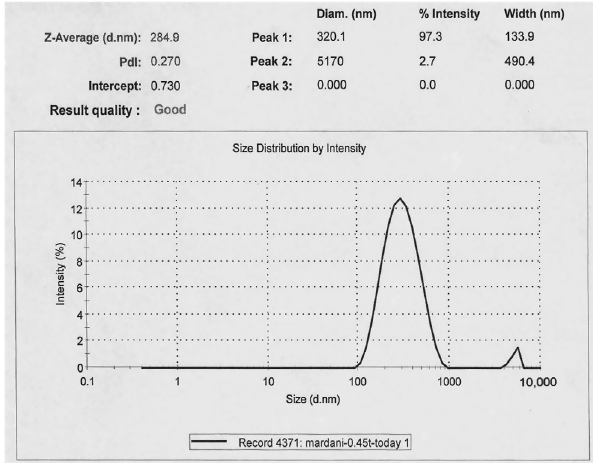
Figure 7 Particle size analysis of nanoparticles (NPs) produced after 48 h